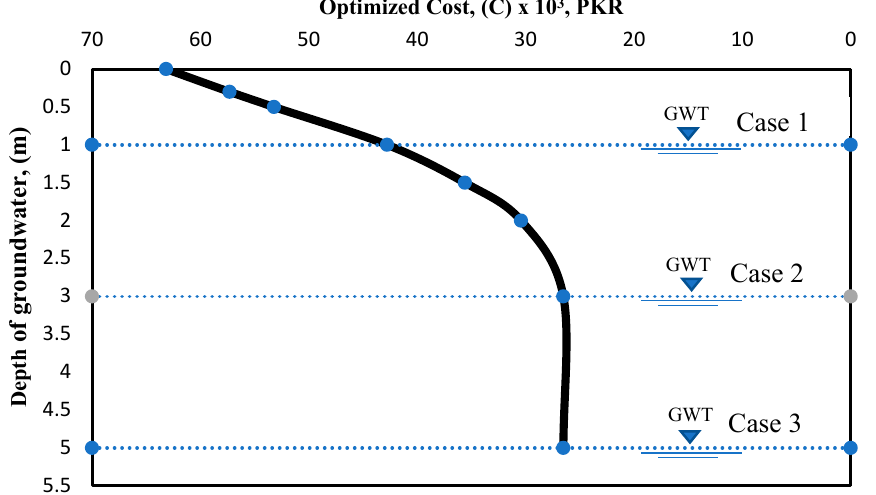
Figure 9. Variation in optimized cost with variation in groundwater table.